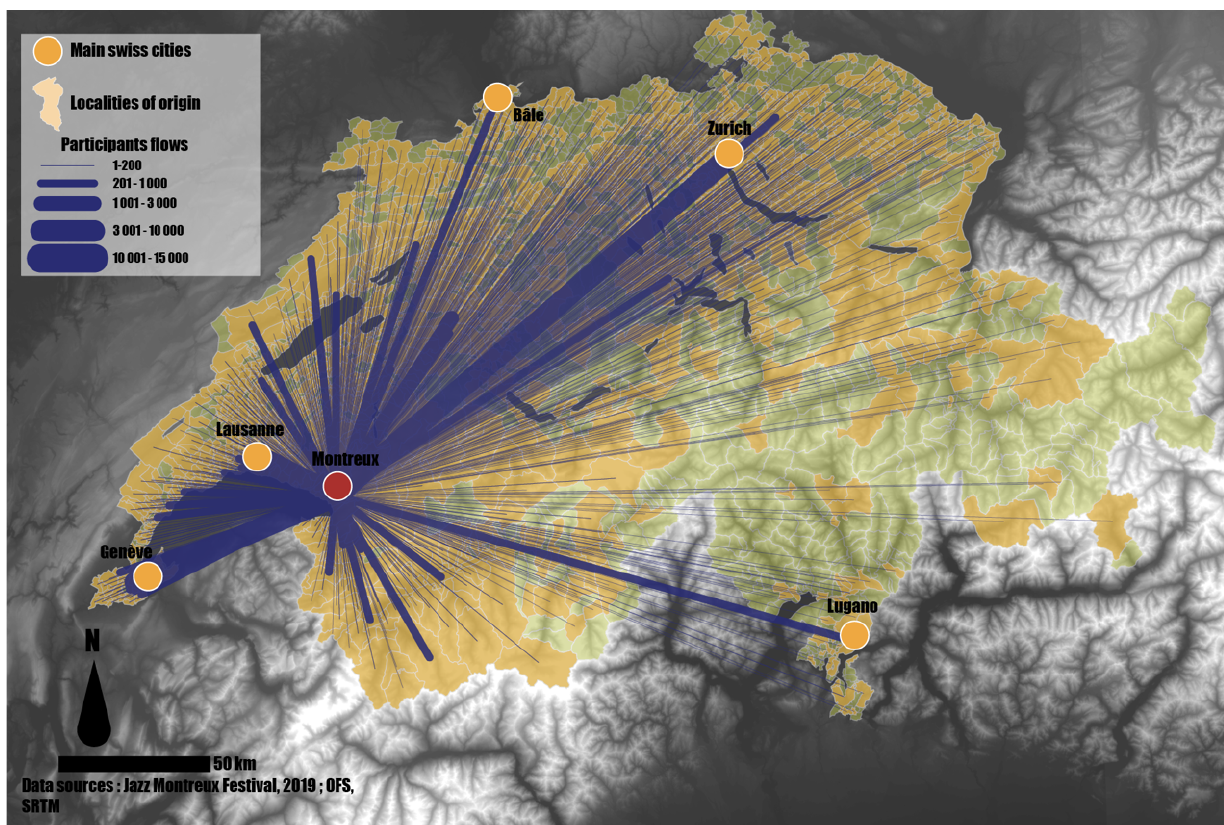
Figure 2. Cartography of the flows of participants to their place of origin. Source: Drevon, Pattaroni, Romany, & Delley (2019).